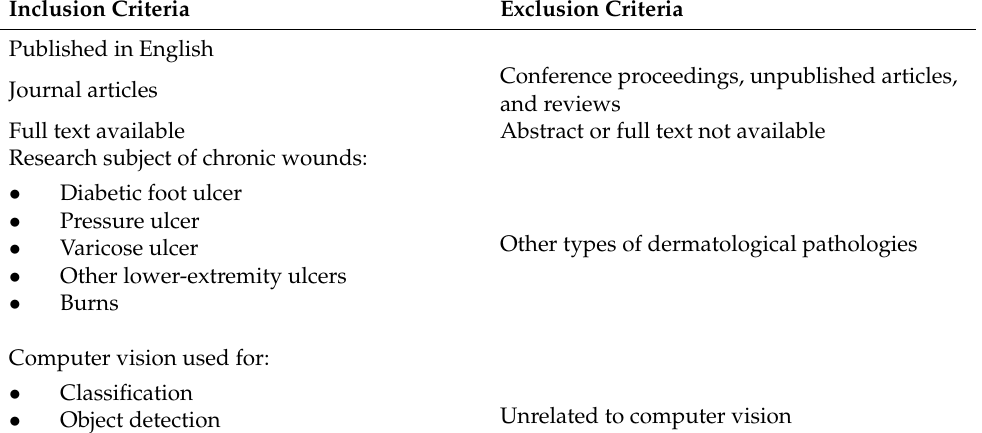
Table 1. Article eligibility